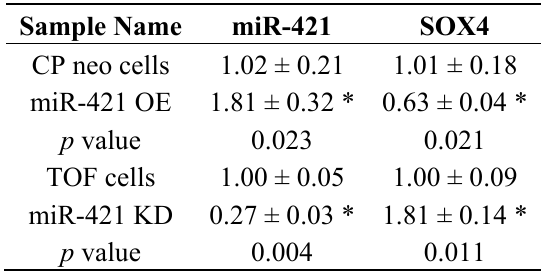
Table 2. SOX4 response to changing levels of